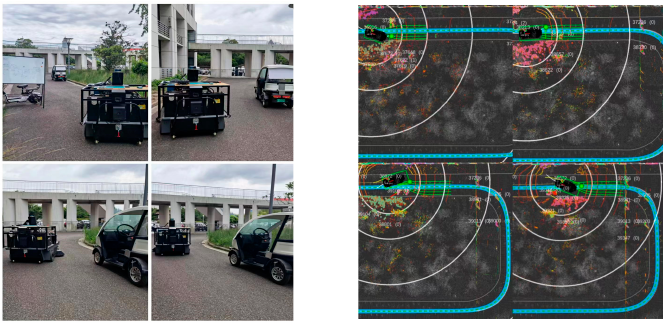
Figure 14. Global planning route. ( a ) Simple environment map; ( b ) complex environment map.